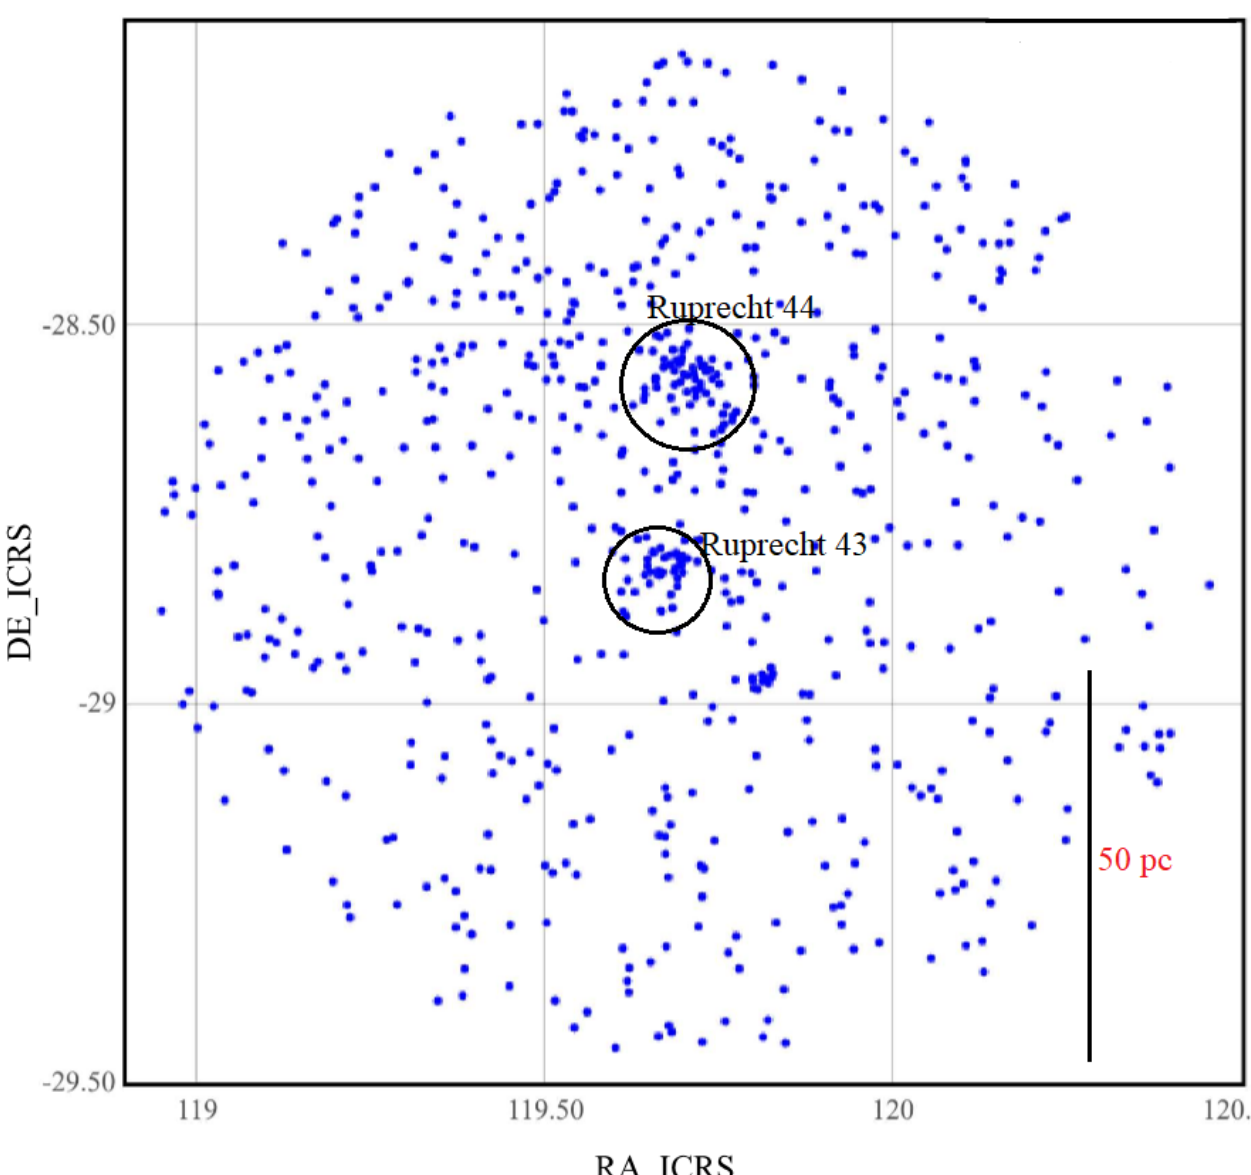
Figure 1. Chart of selected Gaia EDR3 sources defining the candidate group Y. Constraints: plx 0.10 to 0.215 mas; µ α − 2.0 to − 2.4 mas yr − 1 ; µ δ 2.9 to 3.3 mas yr − 1 ; RUWE < 1.4; G < 19. The projected distance bar assumes a heliocentric distance to the group of 5.5 kpc (see text). Table 1. Selected possible OC groups (Gr) and candidate member’s properties studied in this work. Column headings: 1. Group label; 2. OC name; 3. Galactic longitude; 4. Galactic latitude; 5. Parallax; 6. Photometric Distance; 7. PM in right ascension; 8. PM in declination; 9. OC radius; 10. Number of member stars; 11. Age; 12. Radial velocity. Abbreviations: a radius containing 50% of members; c maximum cluster member’s distance to average position; e reexamined using Gaia EDR3 due to insufficient, imprecise or inconsistent reports; f too few stars for a complete characterization; g see text; p protocluster or embedded cluster; ? dubious.